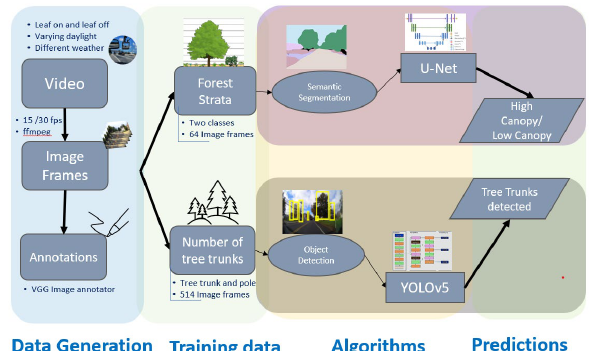
Figure 1: Schematic showing the overall methodology used in the